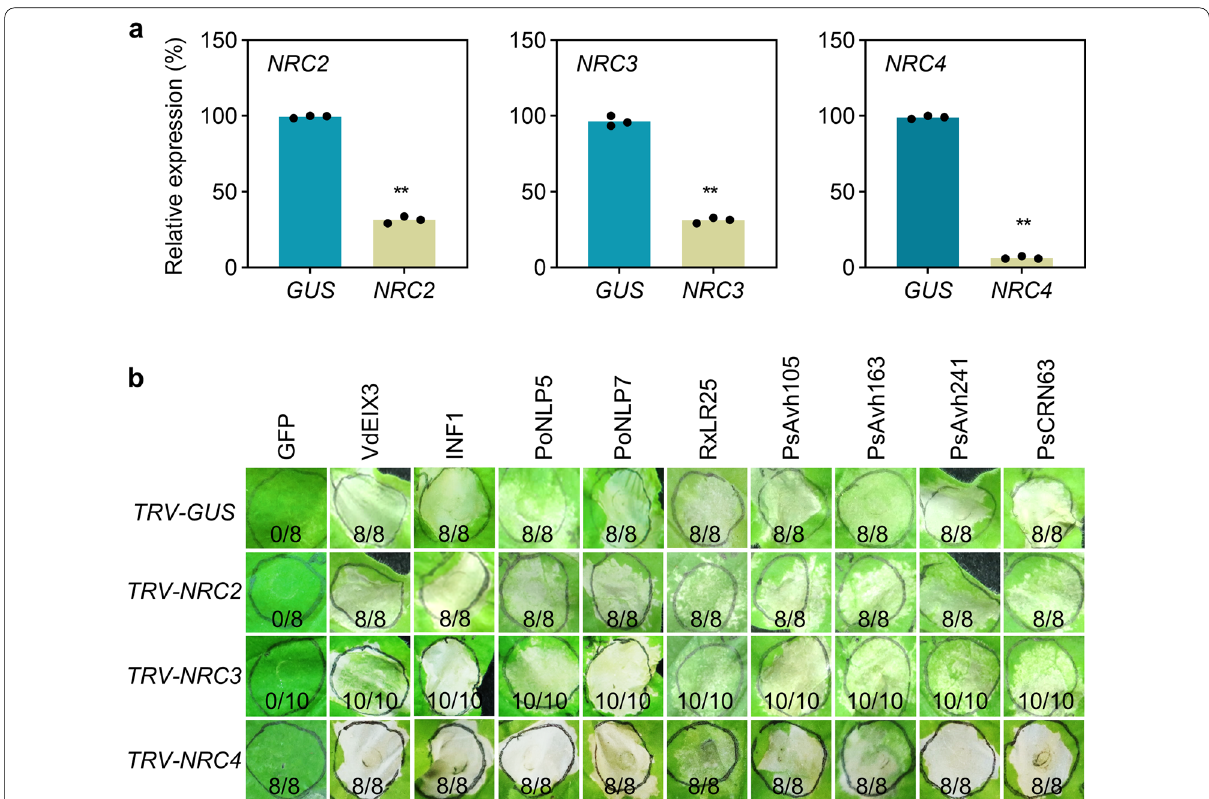
Fig. 4 Silencing individual NRC helper genes has no effect on the cell death triggered by the eight effectors in N. benthamiana . a Silencing efficiency of NbNRC2 , NbNRC3 and NbNRC4 in the indicated gene knock-down N. benthamiana plants. Values represent average P < 0.01 compared with the GUS; Student’s t-test. b Transient expression of effectors in NRC2- , NRC3- , NRC4 -silenced plants. Photographs were taken at 6 dpi. Consistent results were observed from three independent biological experiments, with each having at least eight repetitions. Numbers represent the number of leaves showing cell death out of the number of leaves